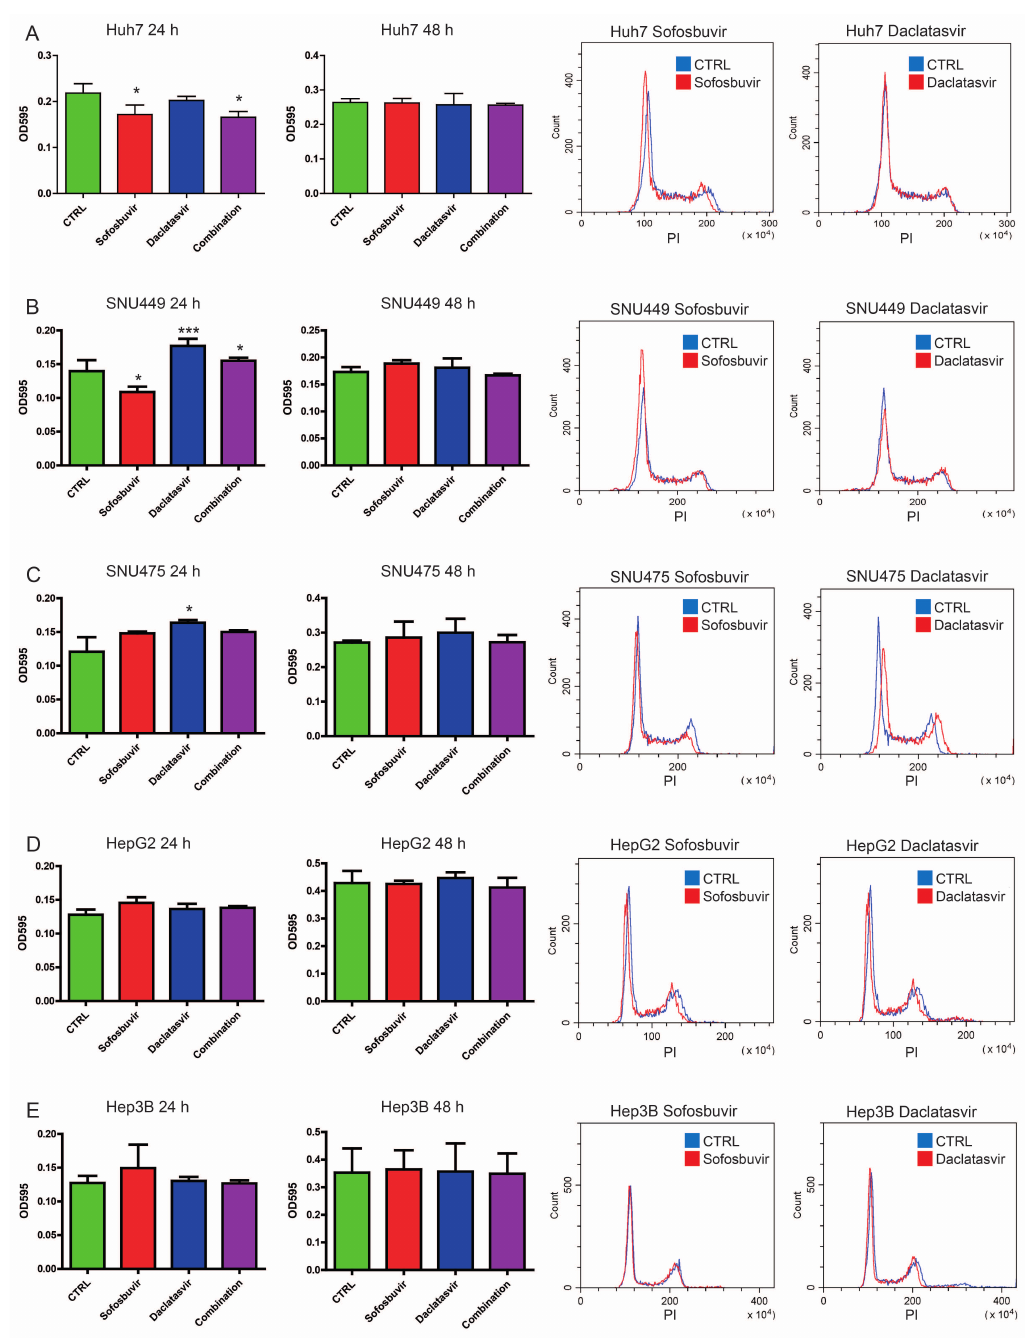
Figure 1. E ff ects of direct-acting antiviral agents (DAAs) on the proliferation and cell cycle of HCC-derived cell lines. Proliferation assay (24 and 48 h) and cell cycle analysis (24 h) of ( A ) Huh7, ( B ) SNU449, ( C ) SNU475, ( D ) HepG2 and ( E ) Hep3B cell lines following treatment with sofosbuvir (4 µ M), daclatasvir (10 nM) and a combination of the two drugs. Control cells (CTRL) were treated with corresponding concentrations of vehicle (dimethyl sulfoxide, DMSO). Student’s t -test was used for comparisons. * p < 0.05, *** p < 0.001. PI: Propidium